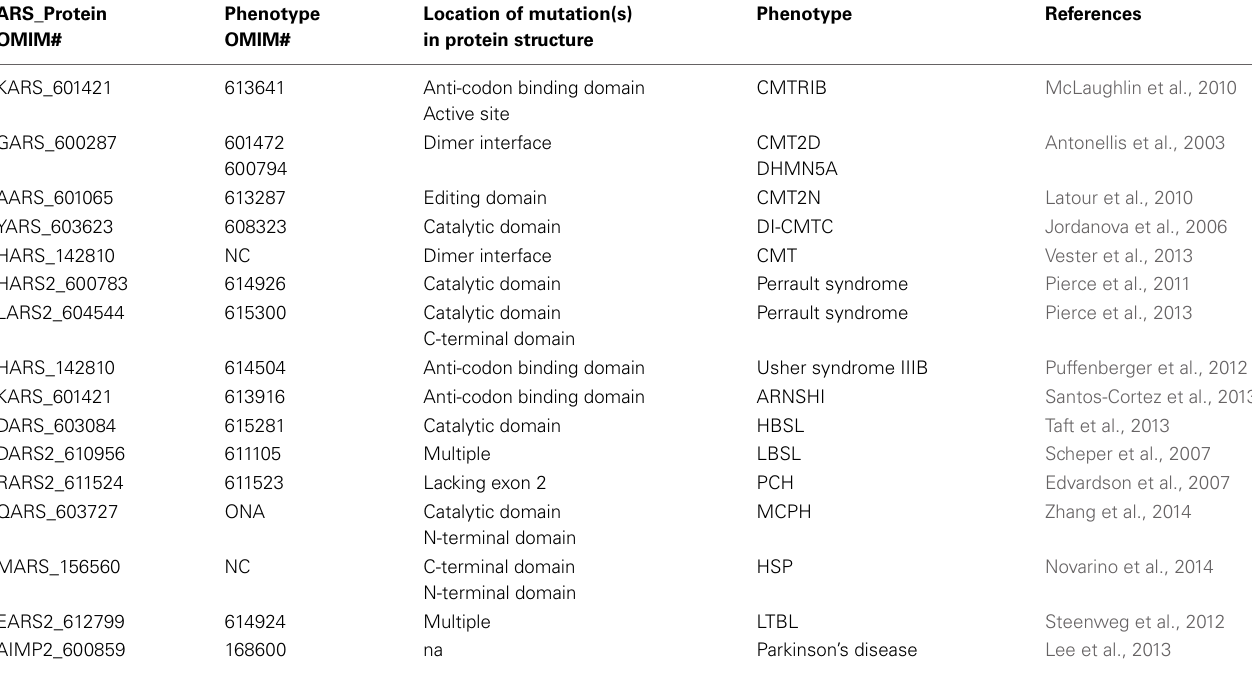
Table 2 | Aminoacyl-tRNA synthetase mutations associated with neurological